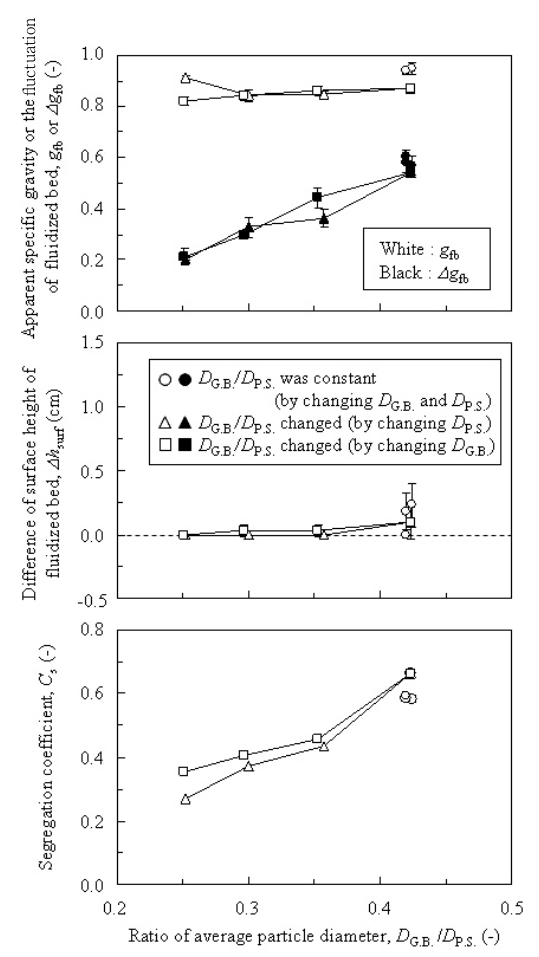
Fig.5 Apparent specific gravity, the fluctuation, surface height of fluid- ized bed and segregation coefficient plotted against ratio of aver- age particle diameter.